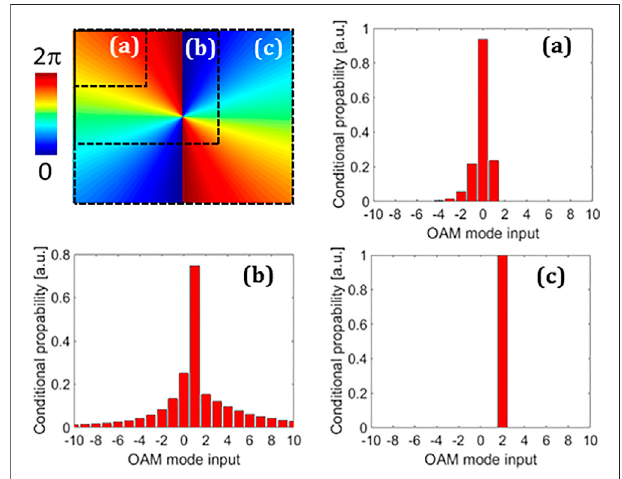
FIGURE 5 | Schematic representation of the lateral displacement calculative method. The entire two-element system moves together in each direction (only the fi rst element is shown).